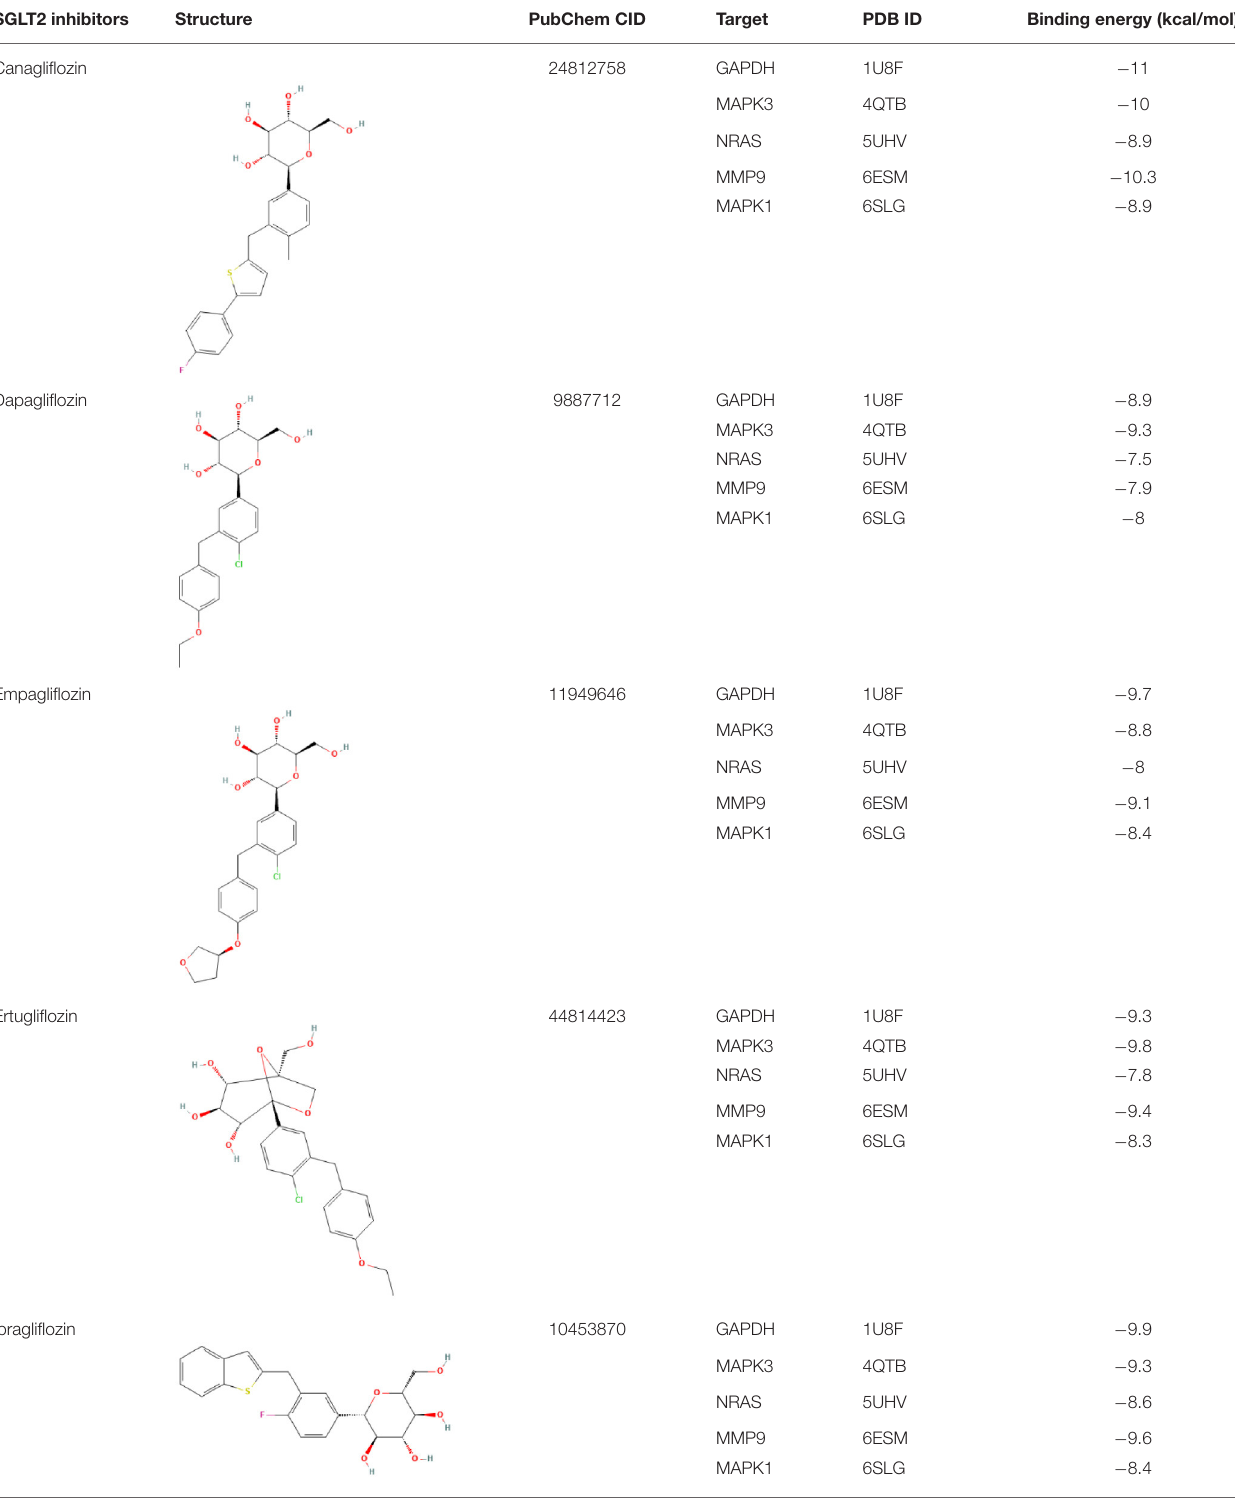
TABLE 3 | Molecular docking results of SGLT2 inhibitors. SGLT2